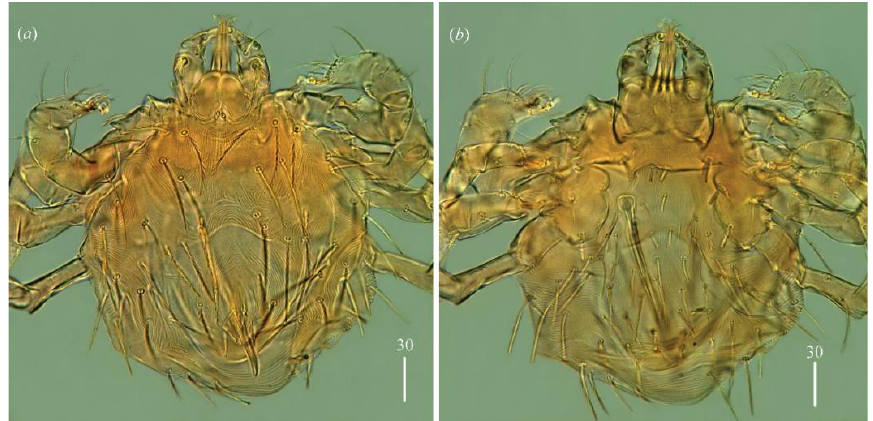
Figure 25. Geckobia phillipinensis Lawrence, 1953 male: ( a ) dorsal view; ( b ) ventral view.